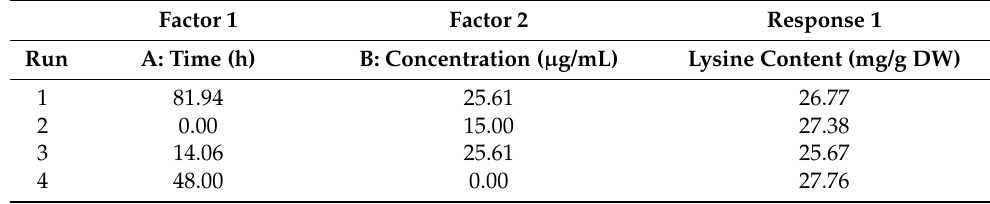
Table 1. Design matrix of